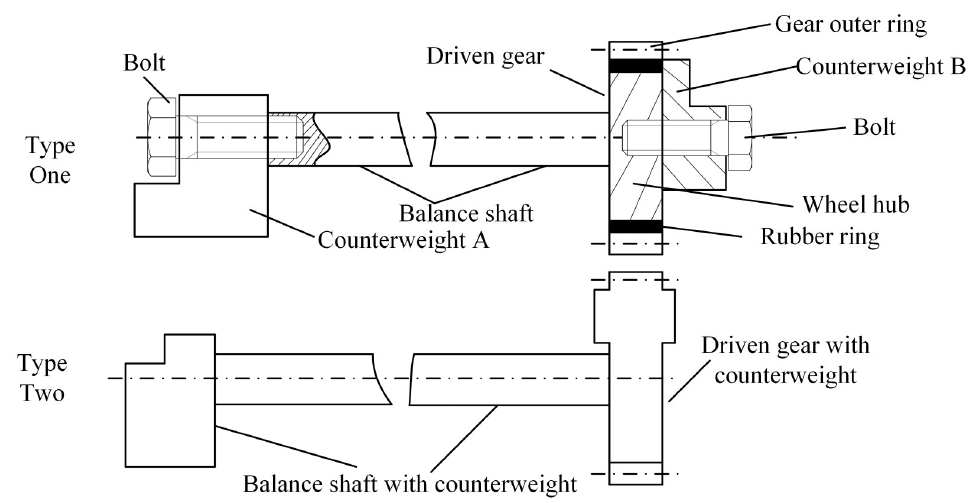
Fig 2. The structure of three-cylinder engine balanced system.